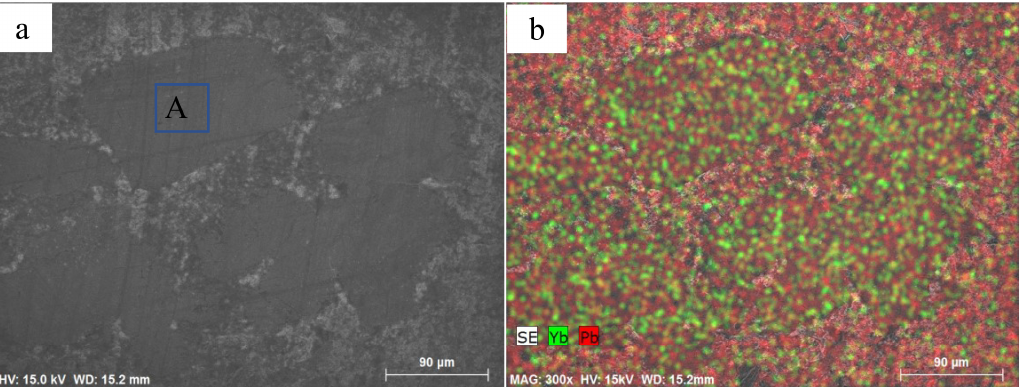
Figure 12. SEM image ( a ) and EDS mapping ( b ) analysis of the deposit obtained by PE at − 1.86 V on a liquid Pb electrode in molten LiCl-KCl-YbCl 3 salts for 14 h at 773 K.